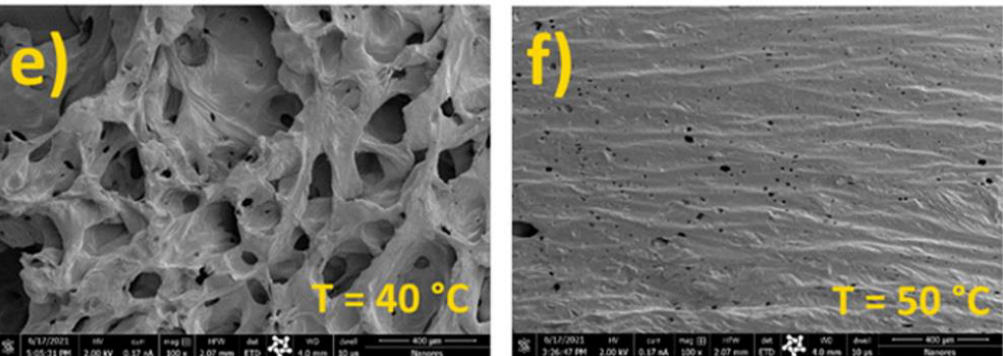
Figure 12. Effect of the impregnation with the carvacrol on the morphology of the neat PCL ( a,b ), PCL-HA 10 ( c,d ) and PCL-HA 20 ( e,f ).